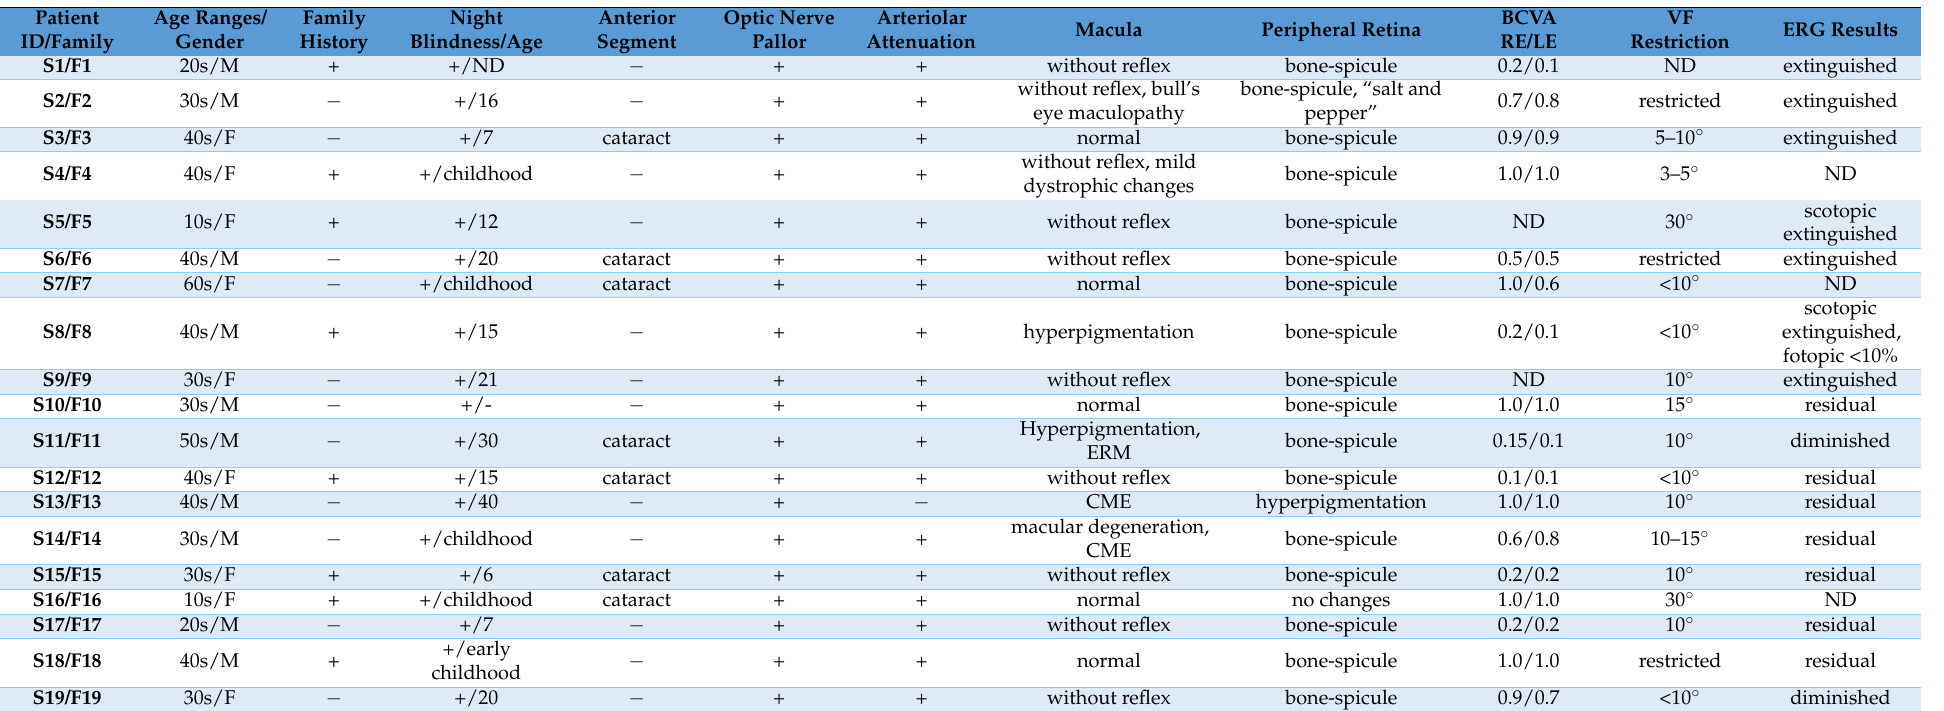
Table 1. Clinical symptoms of patients with